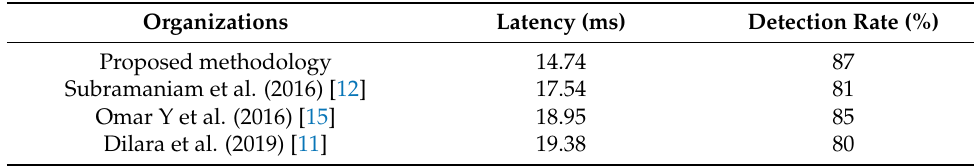
Table 4. Analysis of malicious packet detection rate.